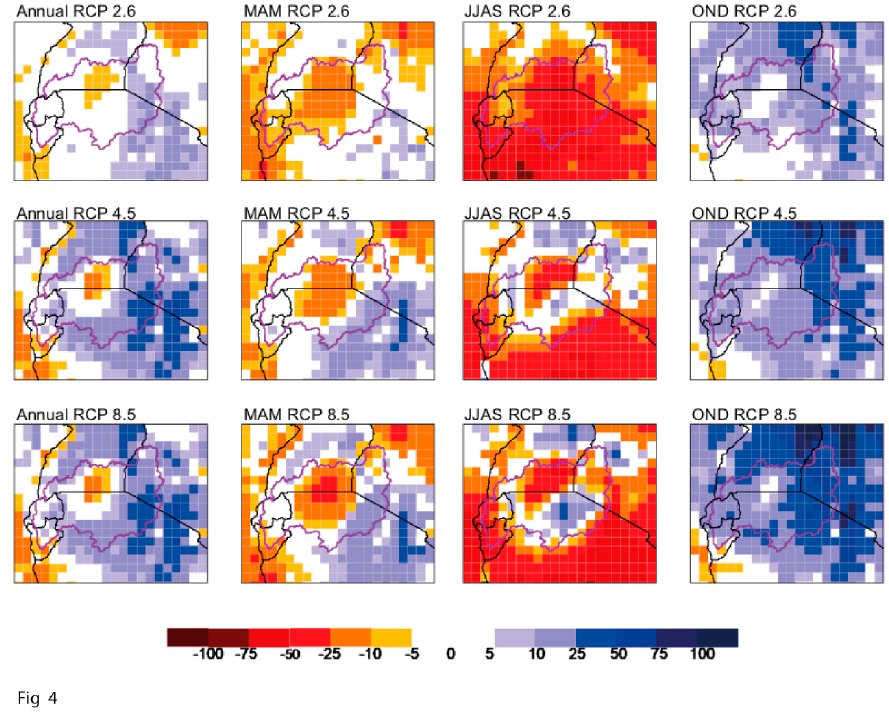
Figure 4. Projected changes in the annual, March–April–May (MAM), June–July–August–September (JJAS), and October–November–December (OND) rainfall components over the Lake Victoria Basin by the 2070s. Each row corresponds to the emission scenarios of RCP 2.6, RCP 4.5, and RCP 8.5.